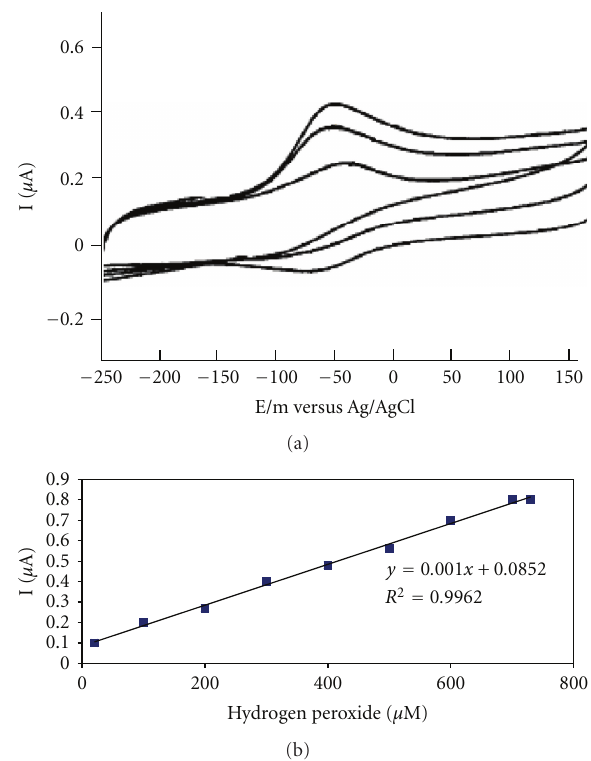
Figure 6: (a) Cyclic voltammograms obtained at an Hb/Mn 2 O 3 -Ag nanofibers/glassy carbon electrode in 50 μ M phosphate bu ff er solu- tion (pH 7.0) for di ff erent concentrations and (b) the relationship between cathodic peak current of Hb and di ff erent concentrations of H 2 O 2 (scan rate: 100 mVs − 1 ).